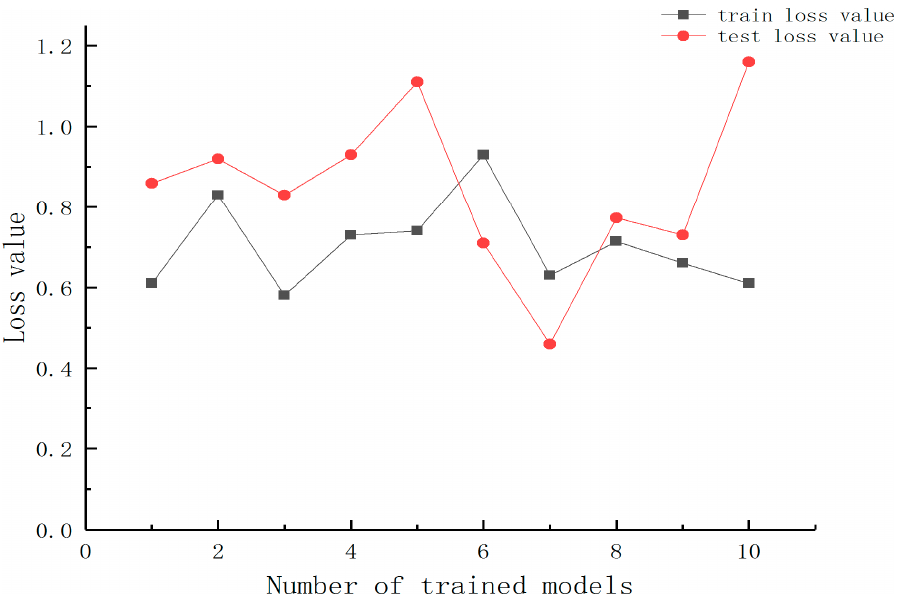
Figure 7. Forecast of training data—Godavari River plateau dataset.